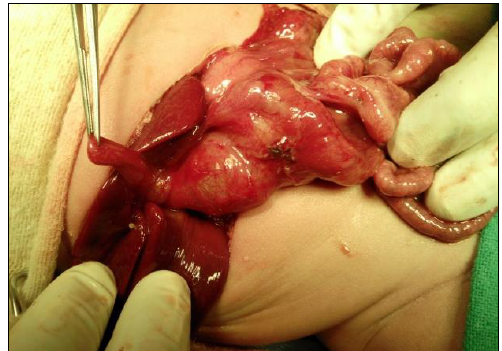
Figure 2: Gall bladder with choledochal cyst. Also note dilated duodenum and atretic small bowel with multiple atresia.